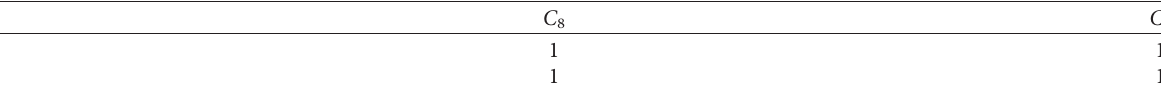
Table 7: Secondary index judgment matrix in U